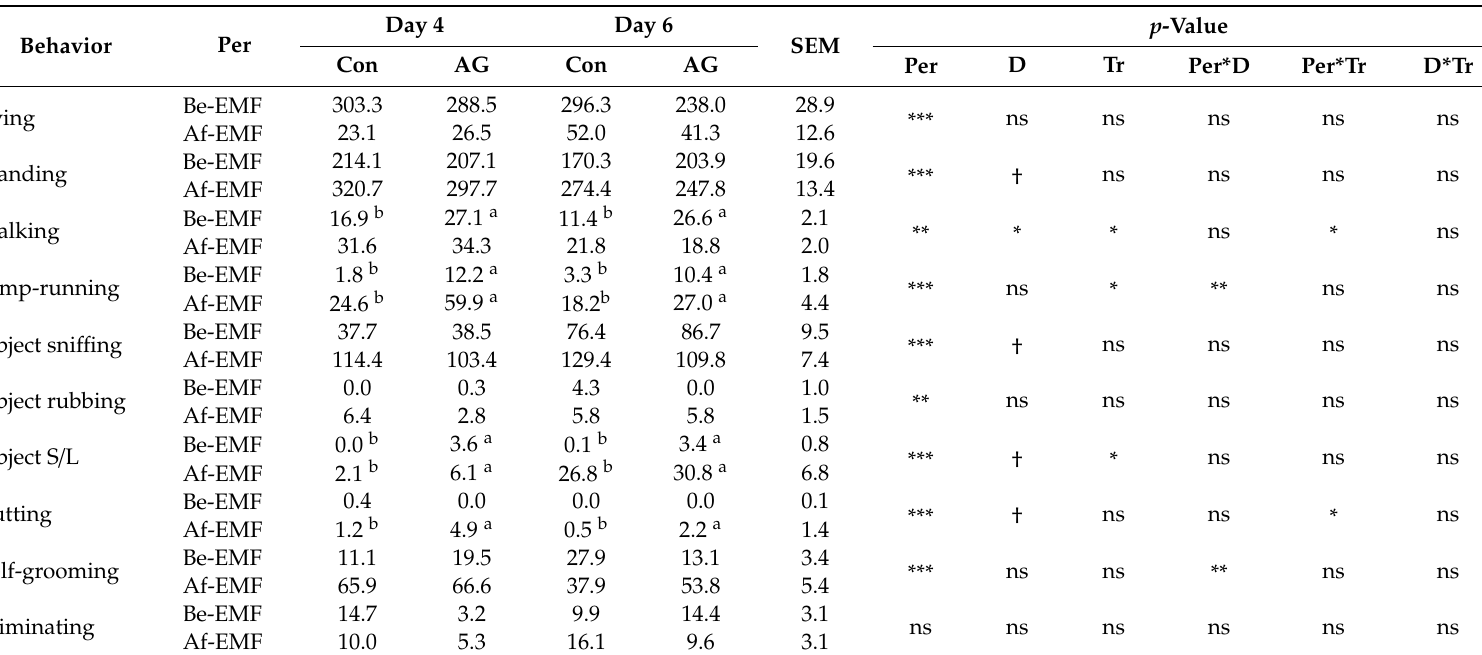
Table 2. The e ff ect of artificial grooming on the behavior duration (s) of Holstein female calves before and after evening milking feeding on days 4 and 6. Behavior